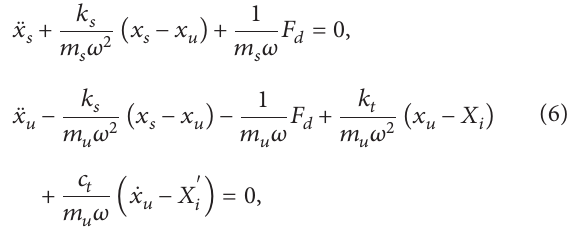
= 1 0.092, 𝑎 = 7 .526, 𝐼 = 0 .069, 𝛼 = 2 0 0 = 1 368.7, 𝑐 = 6 222.7, 0 1 = −0 .004. Figure 3(b) shows 0